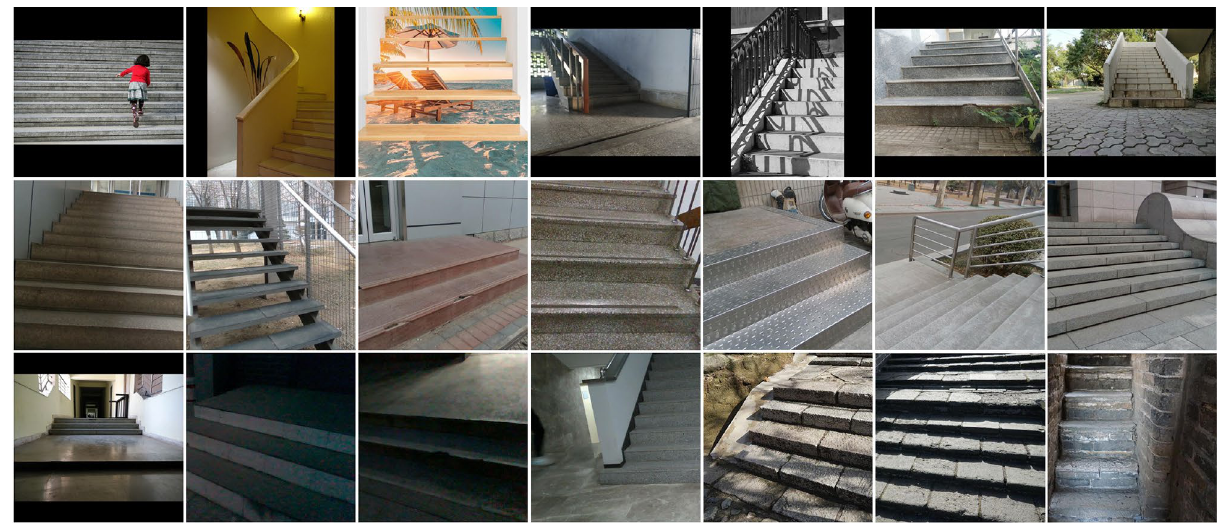
Figure 6. Partial images found in the training